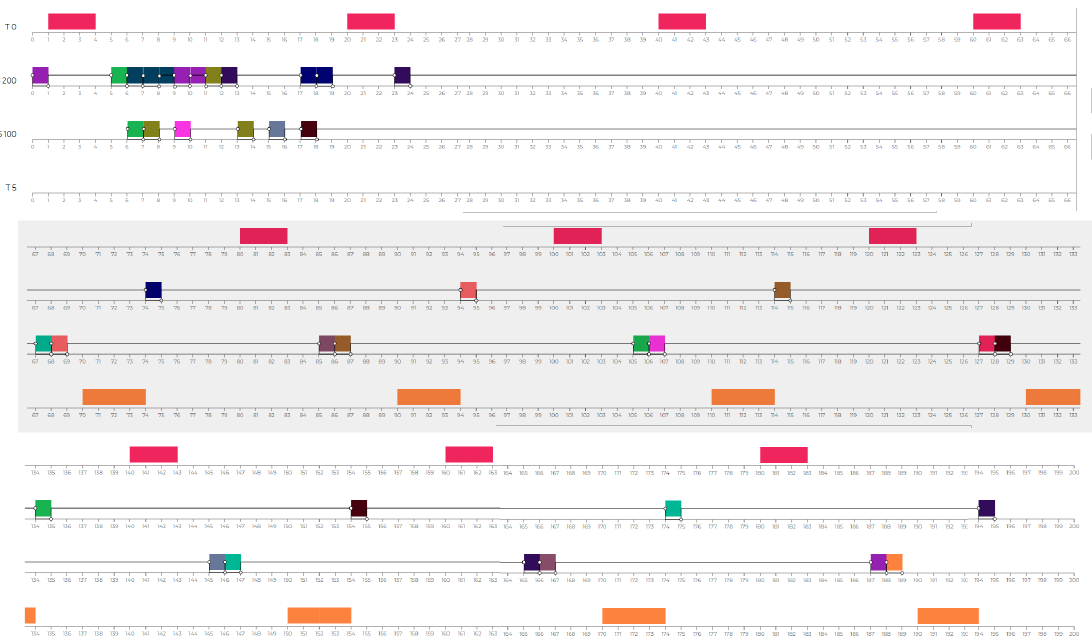
Figure 11. Response time of tasks performed by agent 2 in scenario S1; y-axis: response time (seconds); x-axis: time (seconds).